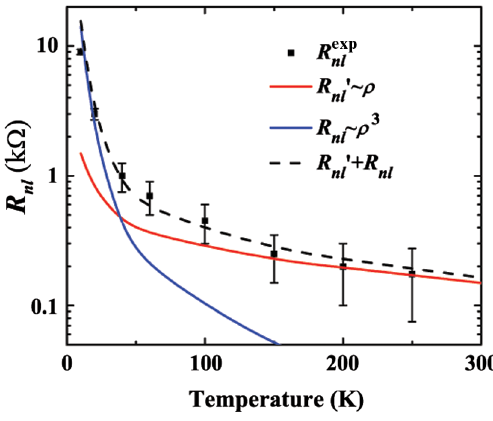
FIG. 12. The peak values (at CNP) of measured nonlocal resistance are plotted as a function of temperature, shown as ∝ black solid squares. The calculated stray current effect R 0 nl ρ ð T Þ is shown by the solid red curve. The blue curve denotes the peak values of topological nonlocal resistance calculated, ∝ ρ 3 ð T Þ , based on Eq. (28) for a fixed ξ ¼ 450 nm. The R is plotted as a nl nl R 0 black dashed curve represents R . It is clear that there is a nl þ nl is shown by crossover from the high-temperature, linear ρ ð T Þ behavior to the nl is amplified by a factor of 7 low-temperature, ρ 3 ð T Þ behavior. The measured data are seen to nl agree with this crossover behavior (dashed curve)